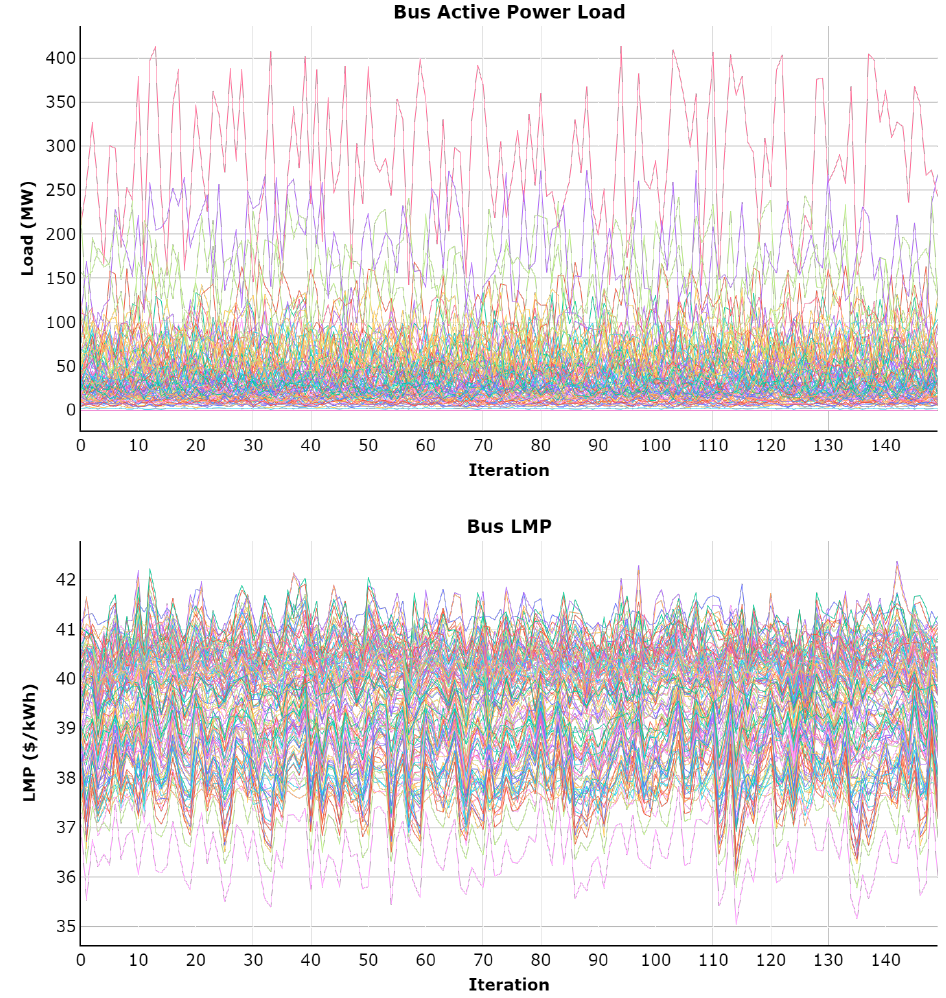
Figure 6. Bus active power load and LMP data produced with Monte Carlo simulations.